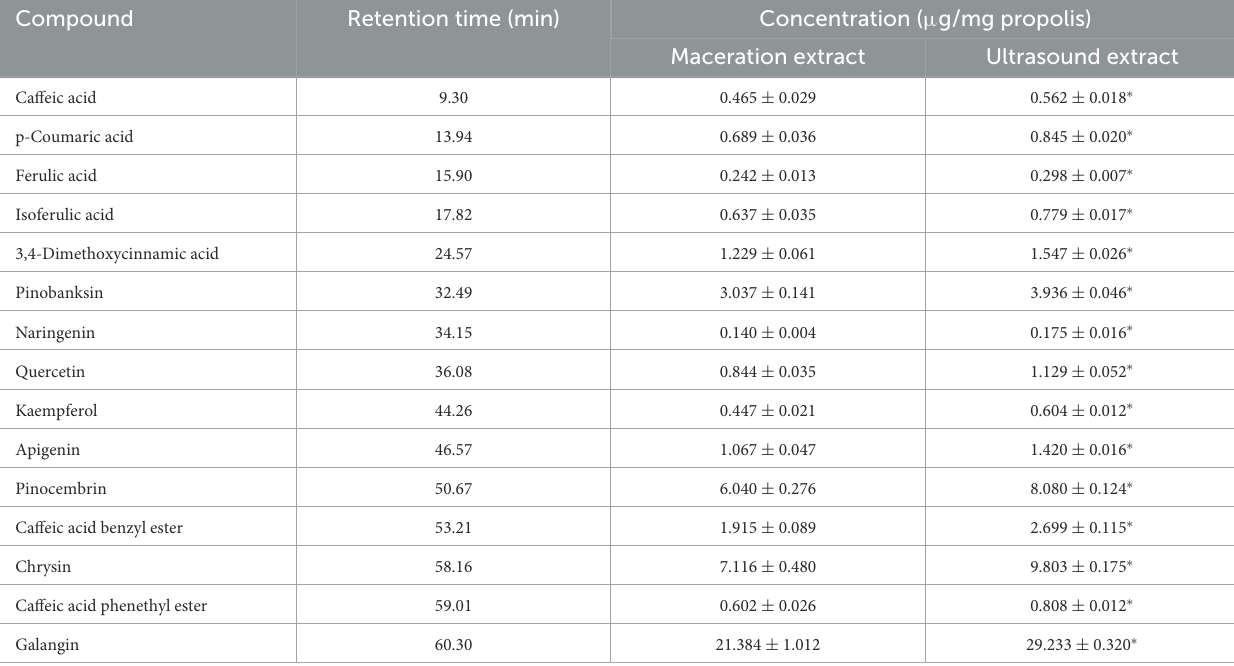
TABLE 3 The content of common compounds of maceration extract and ultrasound extract.